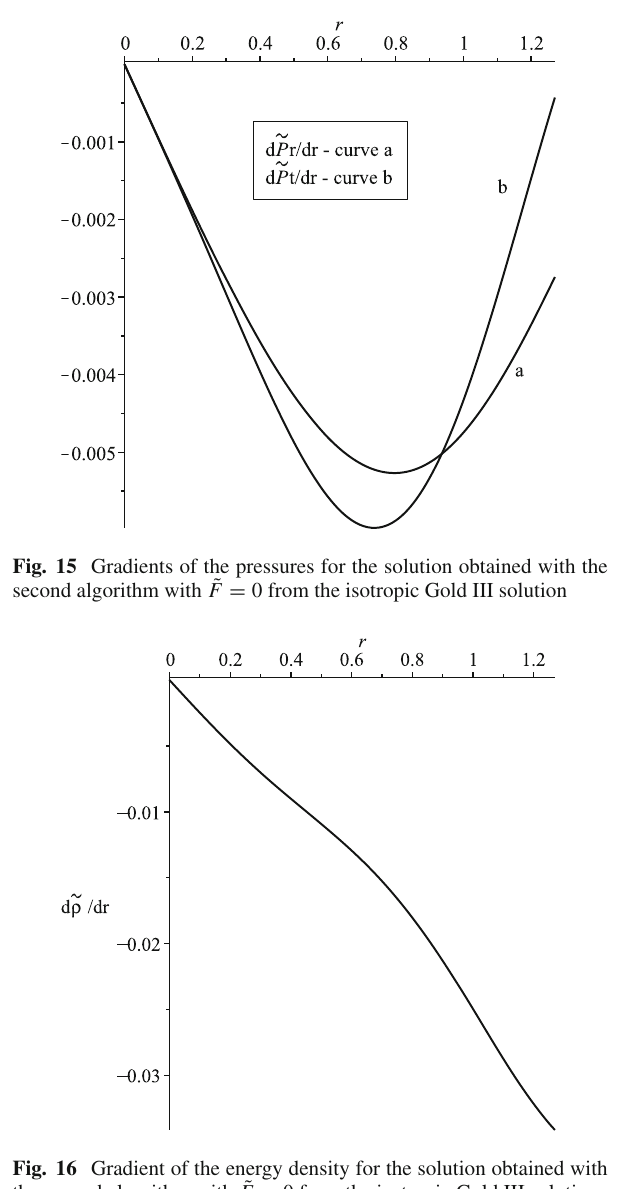
Fig. 18 Causality condition for the solution obtained with the second algorithm with ˜ F = 0 from the isotropic Gold III